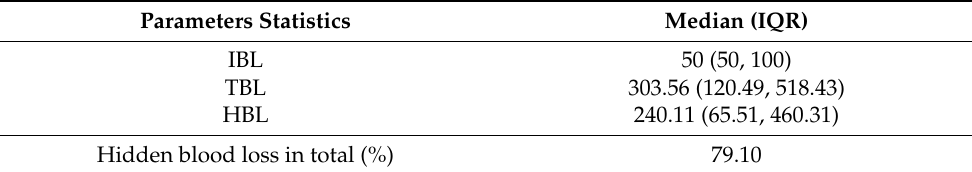
Table 2. Perioperative blood loss in the